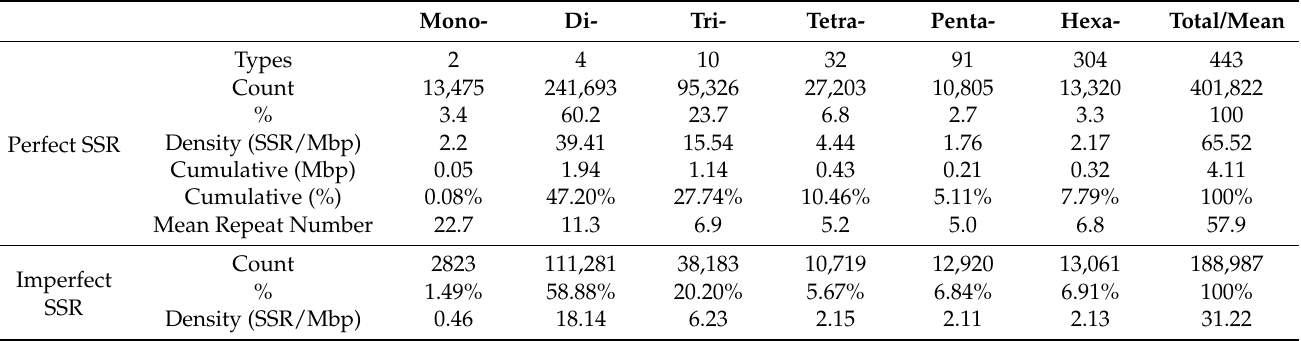
Table 1. Microsatellite motifs distribution across the assembled genome. Perfect (including com- pound) and imperfect SSR are